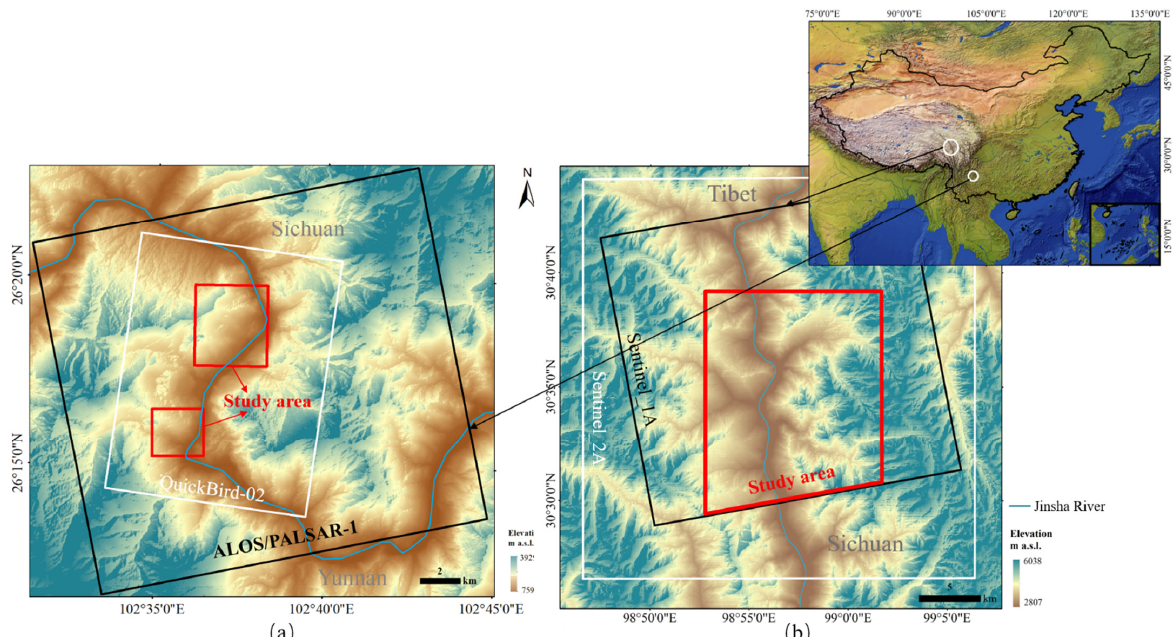
Figure 1. Location of the study area and validation area. ( a ) The first small region near Wudongde Hydropower Station in the lower reaches of Jinsha River, China; ( b ) the second large region in the upper reaches of Jinsha River, China. The black, white and red polygons represent the coverage of SAR, optical images and study area, respectively.